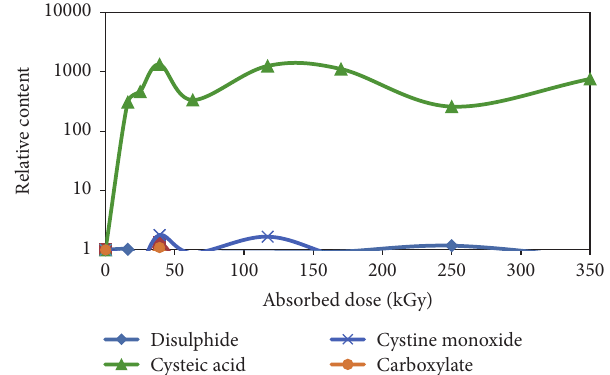
Figure 5: Development of relative content of cysteic acid in the wool with absorbed dose 123 days after electron beam irradiation.